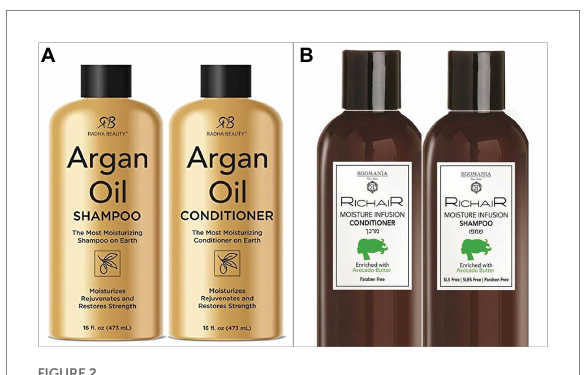
FIGURE 2 Everyday objects tend to be arranged in space according to the mental timeline, which varies in direction across cultures. (A) Typical arrangement of shampoo and conditioner bottles in the US, consistent with a left-to-right mental timeline. (B) Typical arrangement of shampoo and conditioner bottles in Israel, consistent with a right-to-left mental timeline. Reproduced with permission from RozetkaLTD, available at